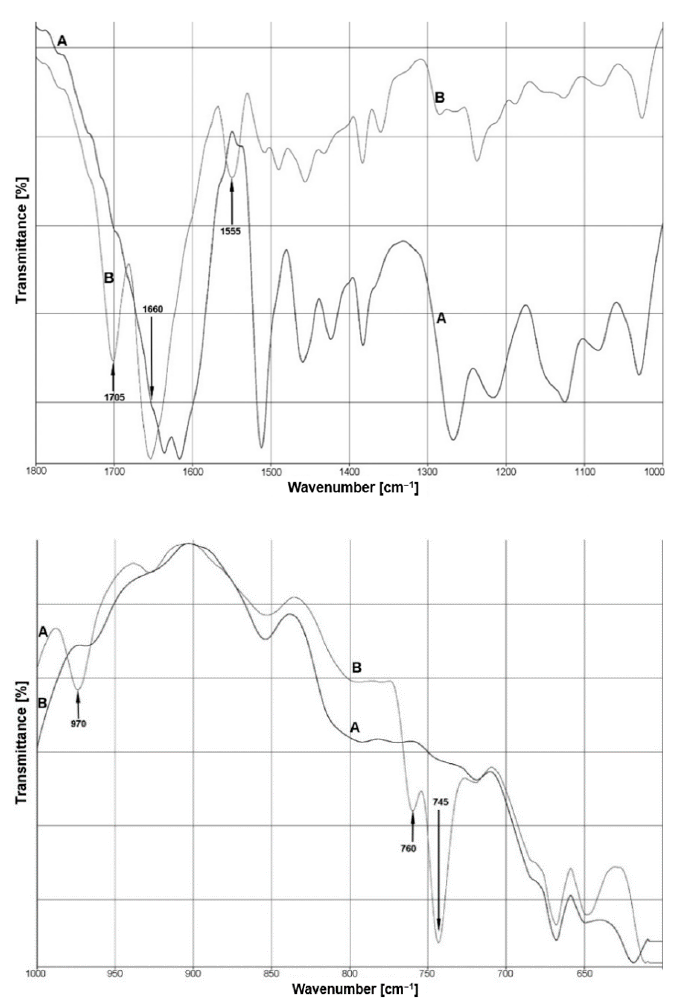
Figure 3. FTIR spectra of lignin (A) and the mixture of lignin with caffeine (B) at the 1800 to 1000 cm − 1 range and at the 1000 to 500 cm − 1 range.